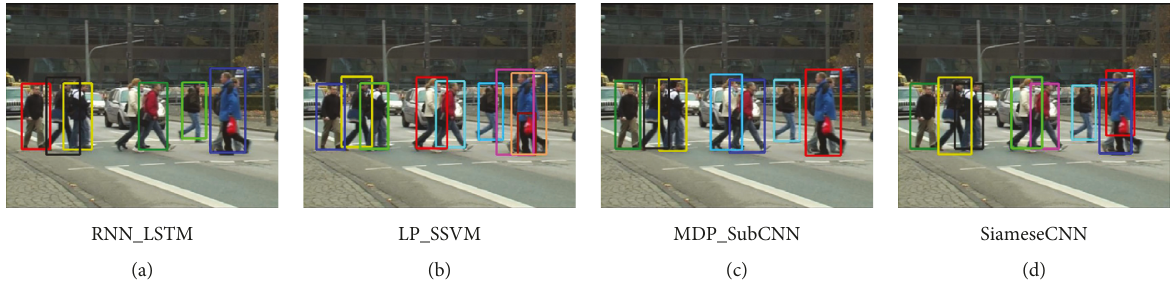
Figure 13: Sample tracking results of other trackers on frame number 45 of